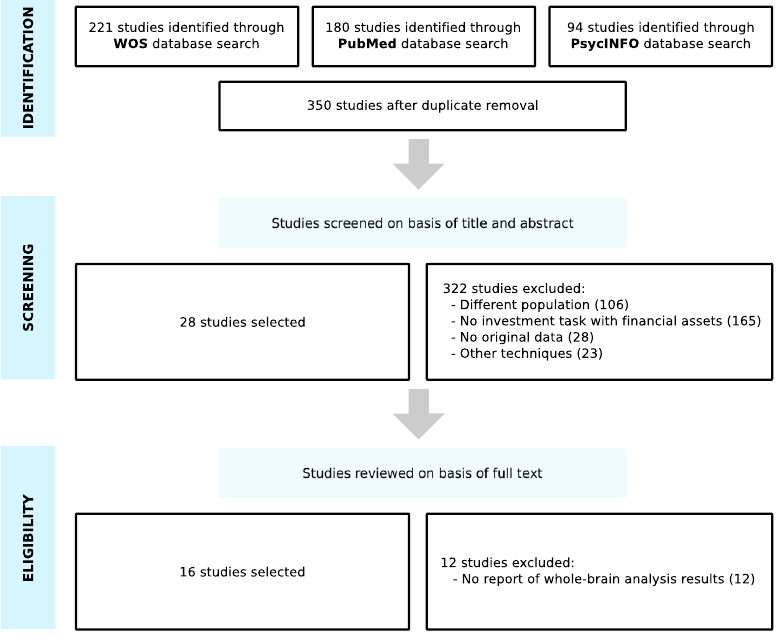
Figure 1. Search flow diagram adapted from PRISMA guidelines.